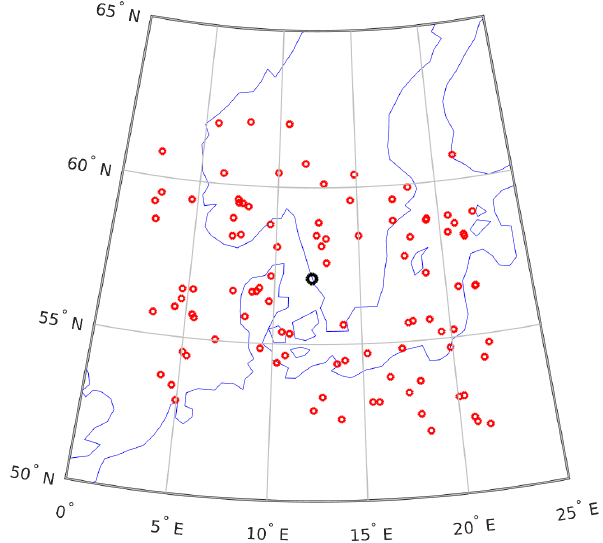
Figure 12. Odin/SMR–OSO coincidences. Red circles show the 89 coincidences during 2002–2007 and the black circle shows the OSO